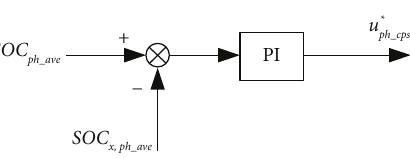
Figure 13: Phase-to-phase SOC equalization correction control.